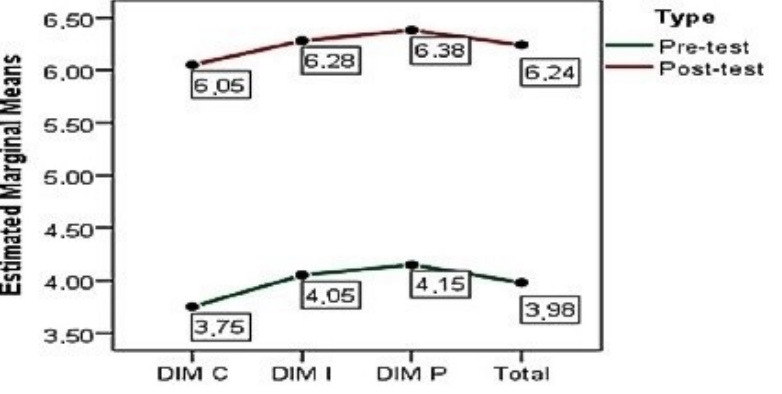
Figure 2. Students’ perceptions before and after applying the FC methodology. Source: own elabo ‐ ration.